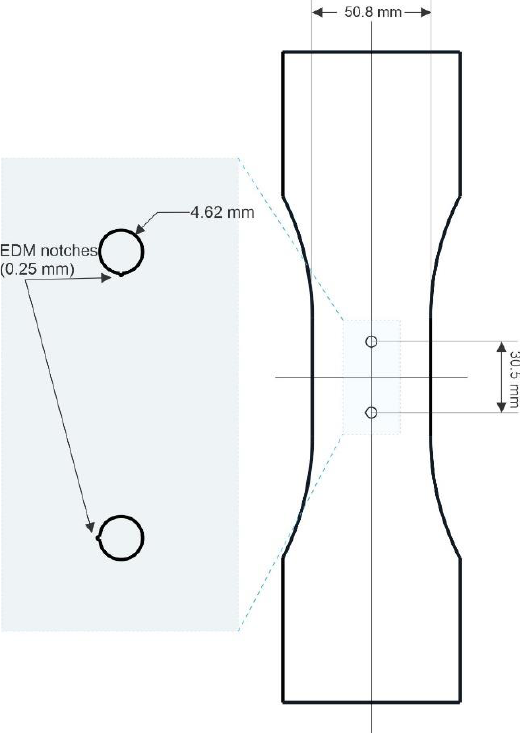
Figure 2. Schematic of the fatigue test coupon, detailing the monitored holes and the EDM notches. The specimen was mounted vertically in a loading frame and clamped using hydrau-